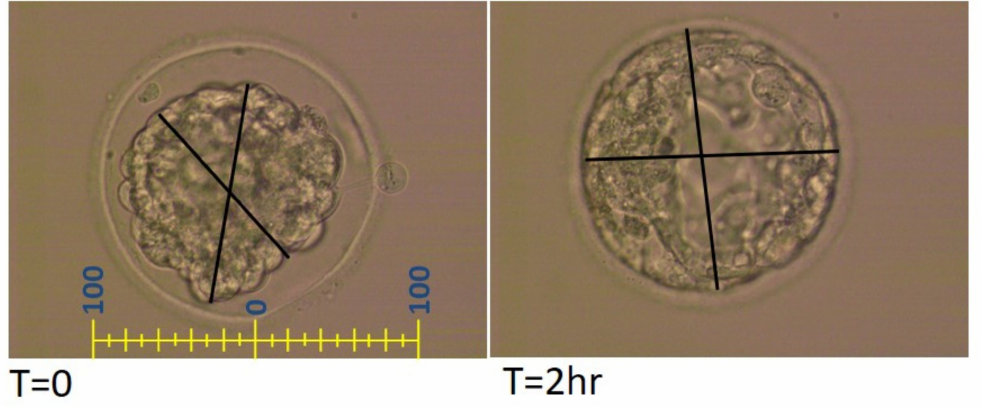
Figure 1. Measurement protocol of thawed